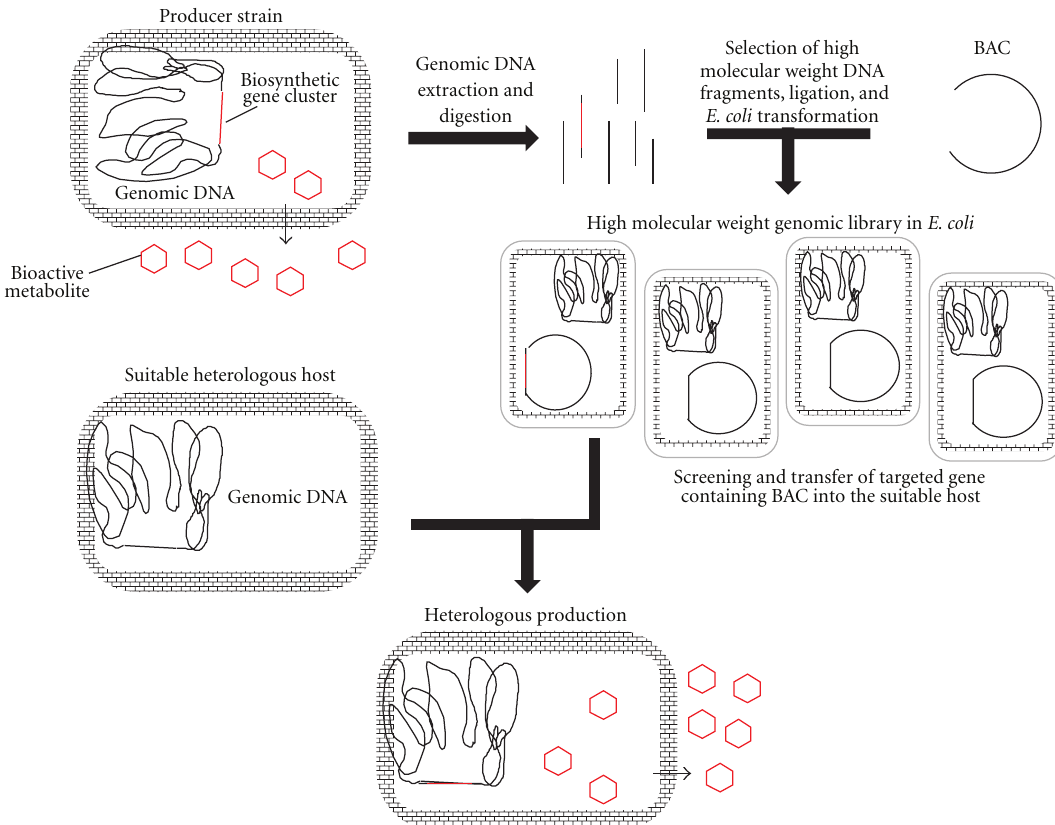
Figure 2: Generalized workflow for heterologous production of natural compounds in an amenable host. A high molecular weight genomic library is constructed and screened to identify one or two clones containing the biosynthetic gene cluster of interest. Once the clone is identified and sequenced to confirm the presence of all the genes, the recombinant vector DNA is used to transform the amenable host. Last, the heterologous production can be improved by changing fermentation process or by genetically manipulating the host.